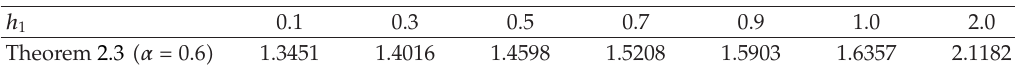
(cid:2) h d (cid:8) 0 . 5 (cid:3) for various h 2